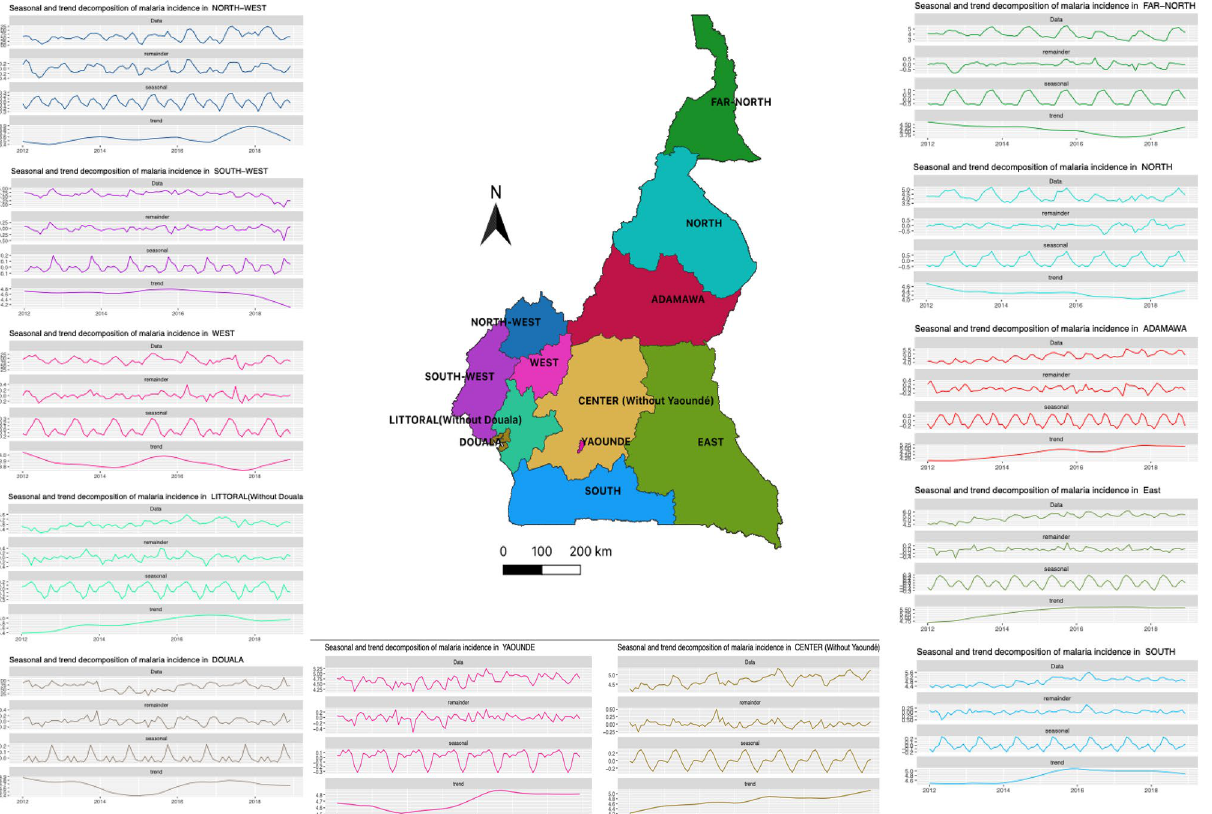
Figure 2. Seasonal-trend decomposition of malaria incidence by region between 2012–2018. Each panel represents the decomposition of malaria incident-cases recorded in health facilities among under-fives in a given region of Cameroon between the years 2012 and 2018. The two largest cities of the country (Douala and Yaoundé) are presented separately, outside the regions where they are located. The names of the regions are mentioned at the top of each panel and the map in the middle gives the geographical location of each region. On each graph, the first curve on the top (Data) represents the raw data, while the last one at the bottom (trend) represents the trend. The two middle curves represent from top to bottom: the remainder and the seasonal component of the seasonal-trend decomposition based on Loess. The map was generated with QGIS version 3.4.8 (URL: https:// qgis. org/ en/ site), and the graphics with the ggplot2 package of R software version 4.0.2 (URL: https:// cran.r- proje ct. org/ web/ packa ges/ ggplo t2/ index.